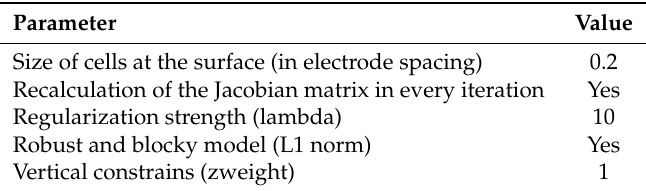
Table 3. Parameters used for the electrical resistivity tomography inversion with the BERT software (Boundless Electrical Resistivity Tomography) in the exemplary